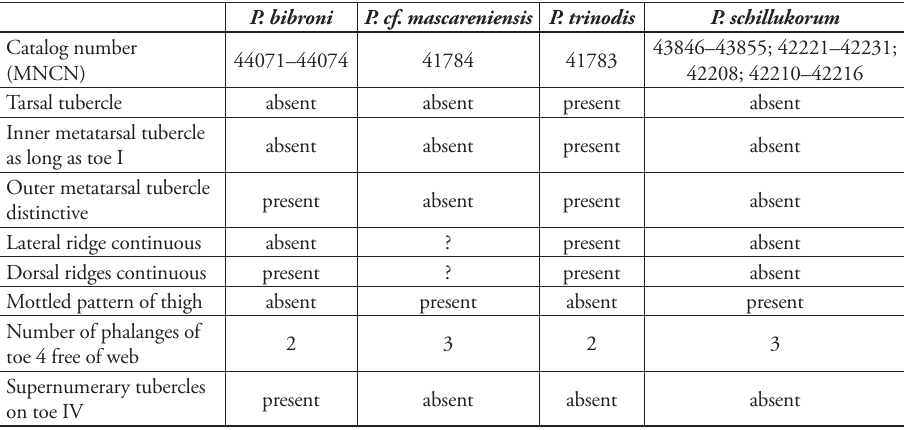
Table 1. Morphological characters of MNCN voucher specimens used in this study for comparing be- tween the species of Ptychadena present in Mauritania.